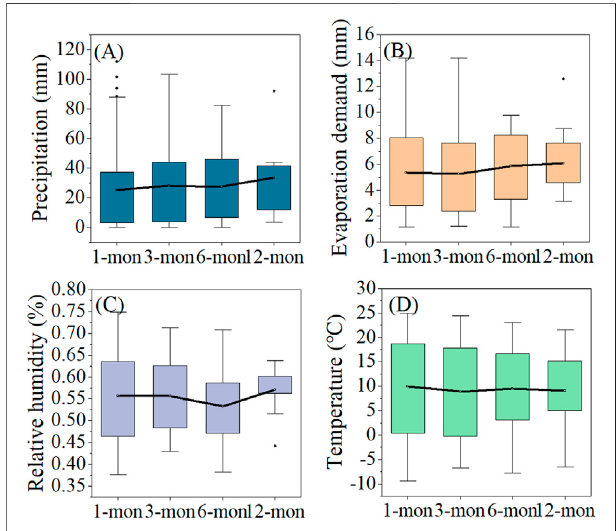
FIGURE 8 | Differences in the values of different contributing variables ( (A) Precipitation (P); (B) Evaporation demand (E0); (C) Relative humidity (Rh); (D) Temperature (T)) to the SPEI at different